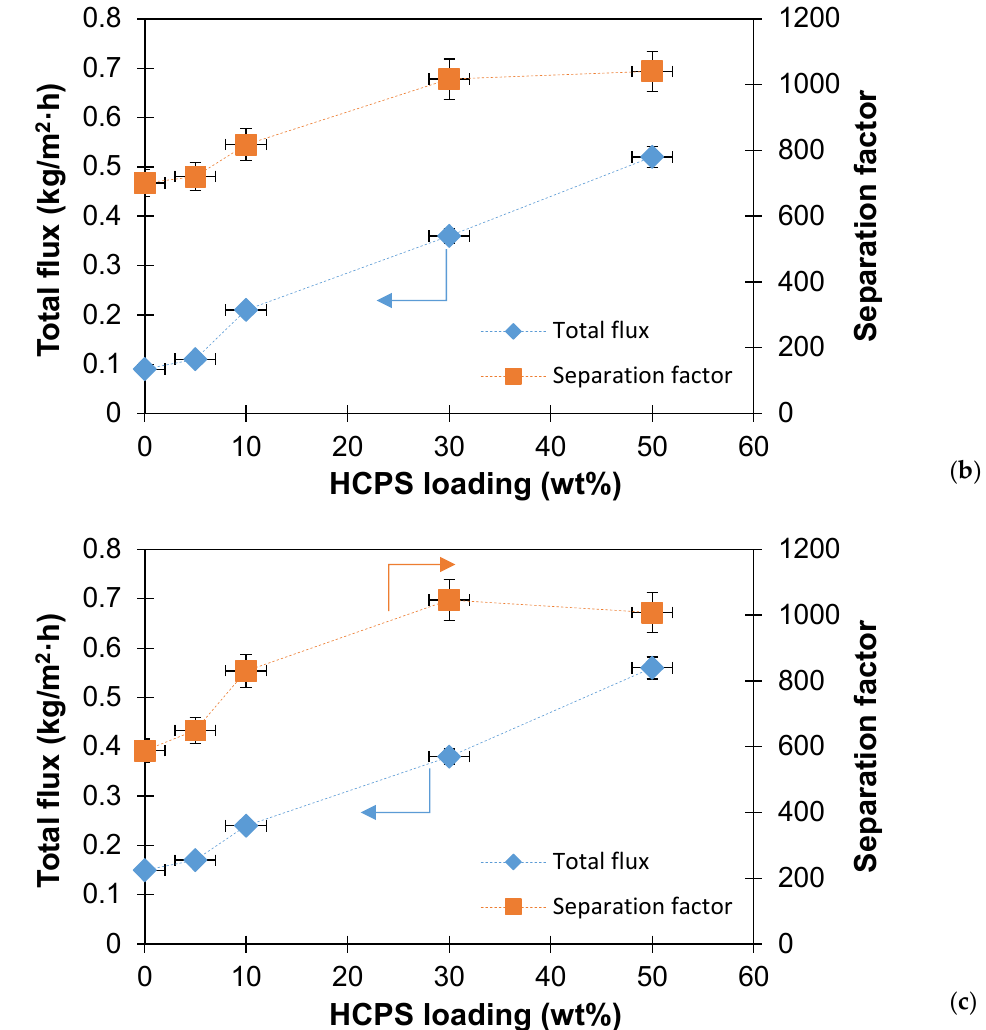
Figure 6. Dependence of permeate flux and separation factor on HCPS loading into PTMSP during the pervaporation separation of binary solutions benzene-water ( a ), toluene-water ( b ), o-xylene-water ( c ).